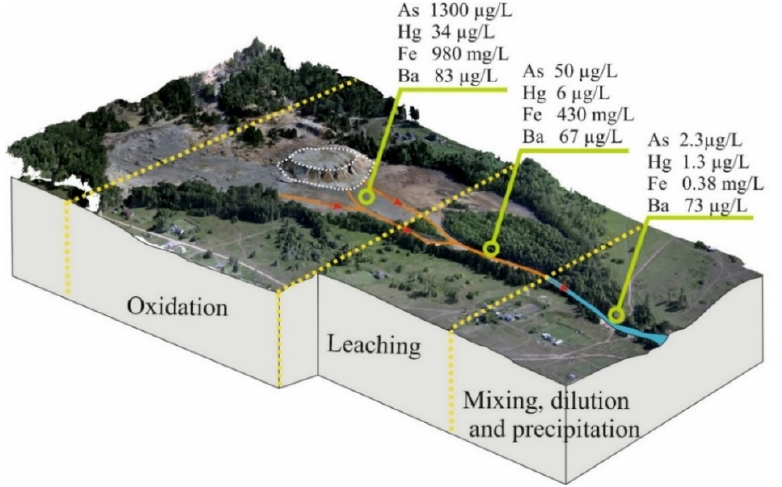
Figure 12. Schematic diagram of the structure of the Ursk drainage system: the distribution of oxidation, leaching, and mixing zones.